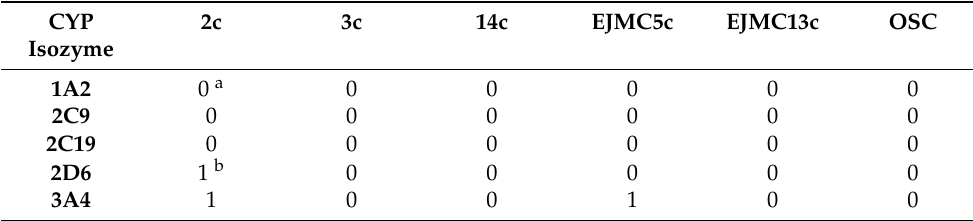
Table 4. Inhibitory ability on CYP1A2, CYP2C9, CYP2C19, CYP2D6 and CYP3A4 of compounds 2c , 3c , 14c , EJMC5c , EJMC13c and OSC .